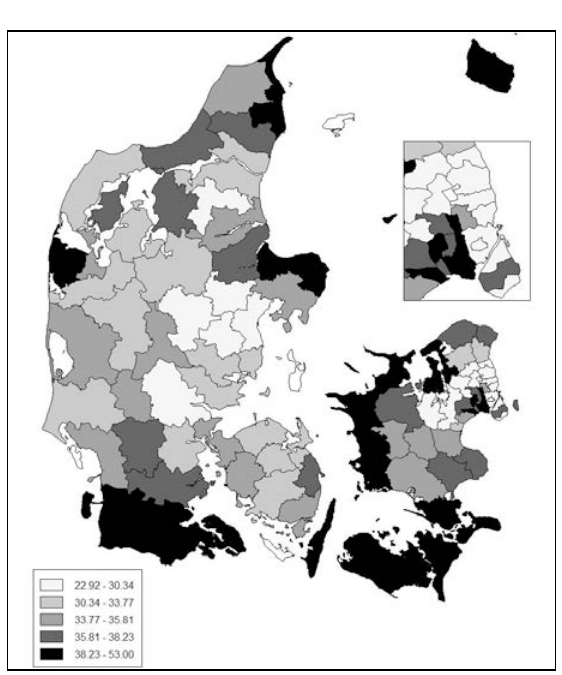
Figure 1. Number of medicated for type 2 diabetes per 1000